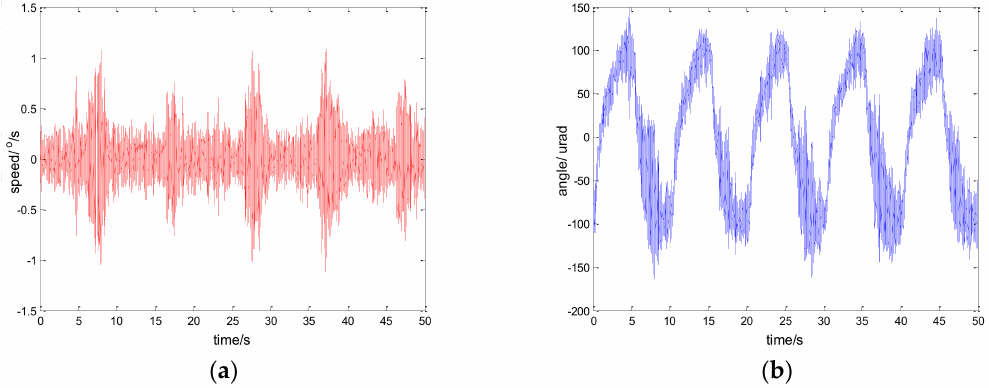
Figure 15. Experiment results of PI control. d = 6sin ( 2 π × 0.1 t ) : ( a ) speed; and ( b ) tracking error, RMS = 73.4717 urad.